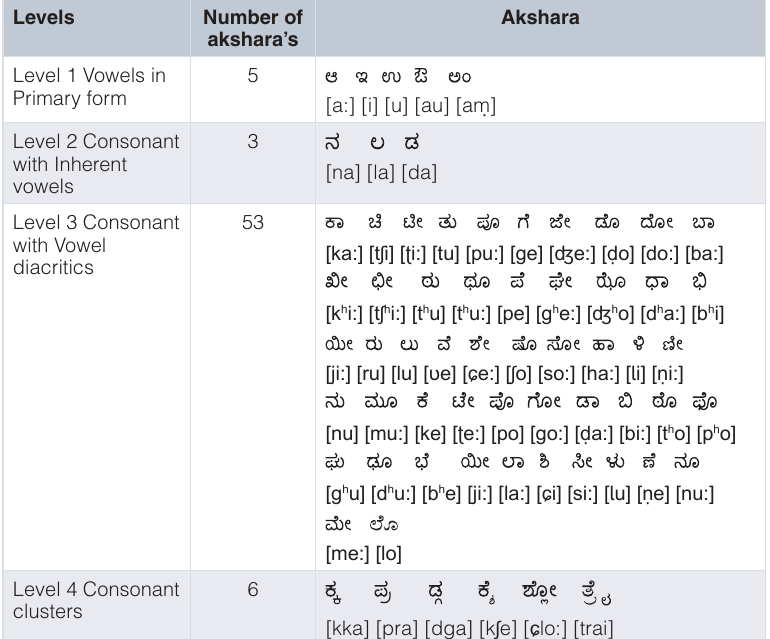
Table 2. The representation of sample of Kannada aksharas at different levels.